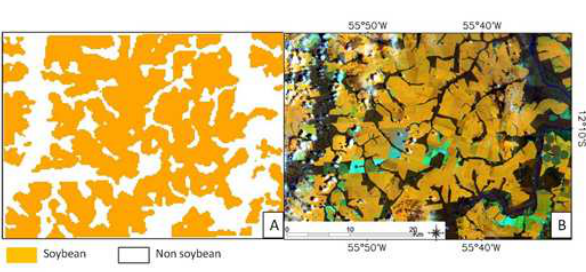
Figure 3. Sector enlargement in Mato Grosso State, for comparison between (A) soybean map classification from MCDA (2 nd forecast) in 2010/2011 harvest and (B) Landsat TM5, orbit 227068, image (RGB/453) in January, 7, 2011. For an average of the nine harvests studied, the MCDA explained 96% of the variation of the data estimated by the IBGE. The test of b0 = 0 indicated that b0 was significantly different from zero ( α = 0.05) for all tested crop years. This parameter with a positive value around 4,000ha indicates that in general, municipalities with lower values of soybean area